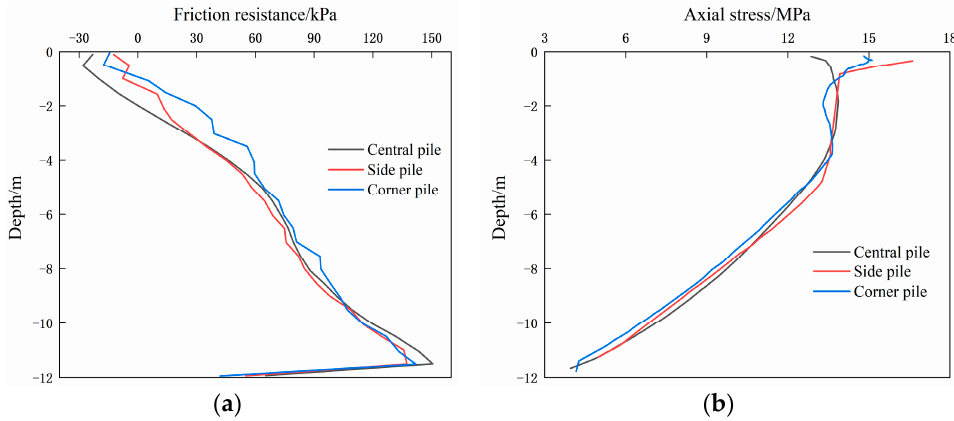
Figure 14. Each pile with the pile spacing 3d1: ( a ) friction resistance; ( b ) axial